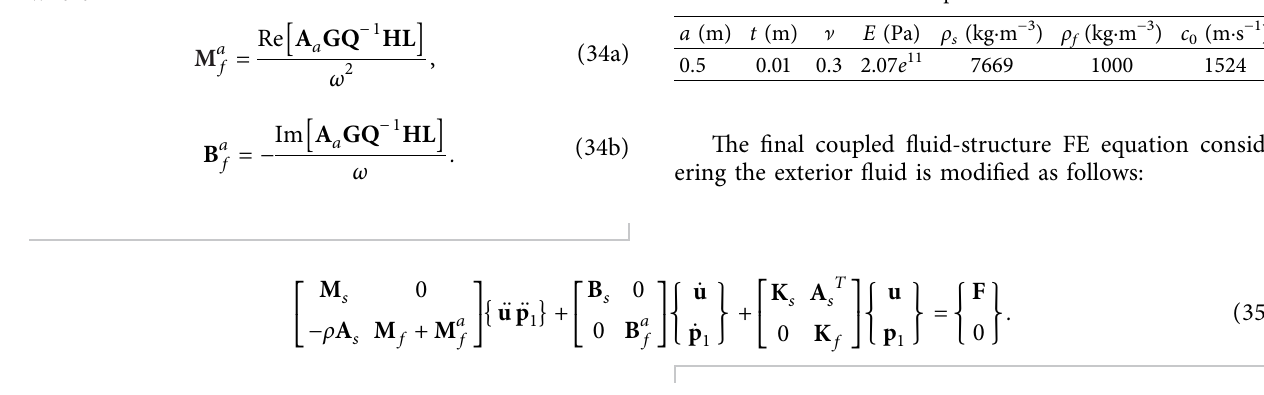
Table 1: Properties of